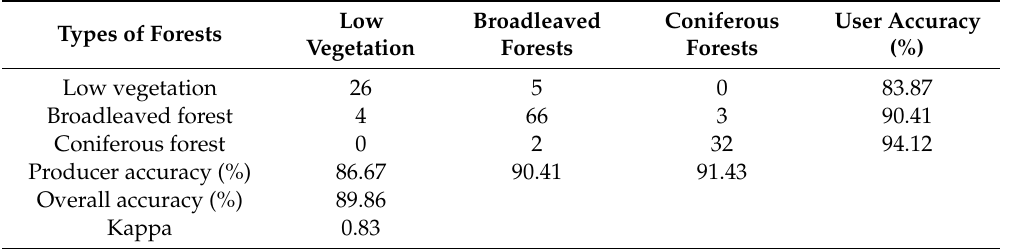
Table 5. Confusion matrix of M4 (SF + DEM + TF + VA). Each row designates the classification result, and each column designates the field-based validation data.